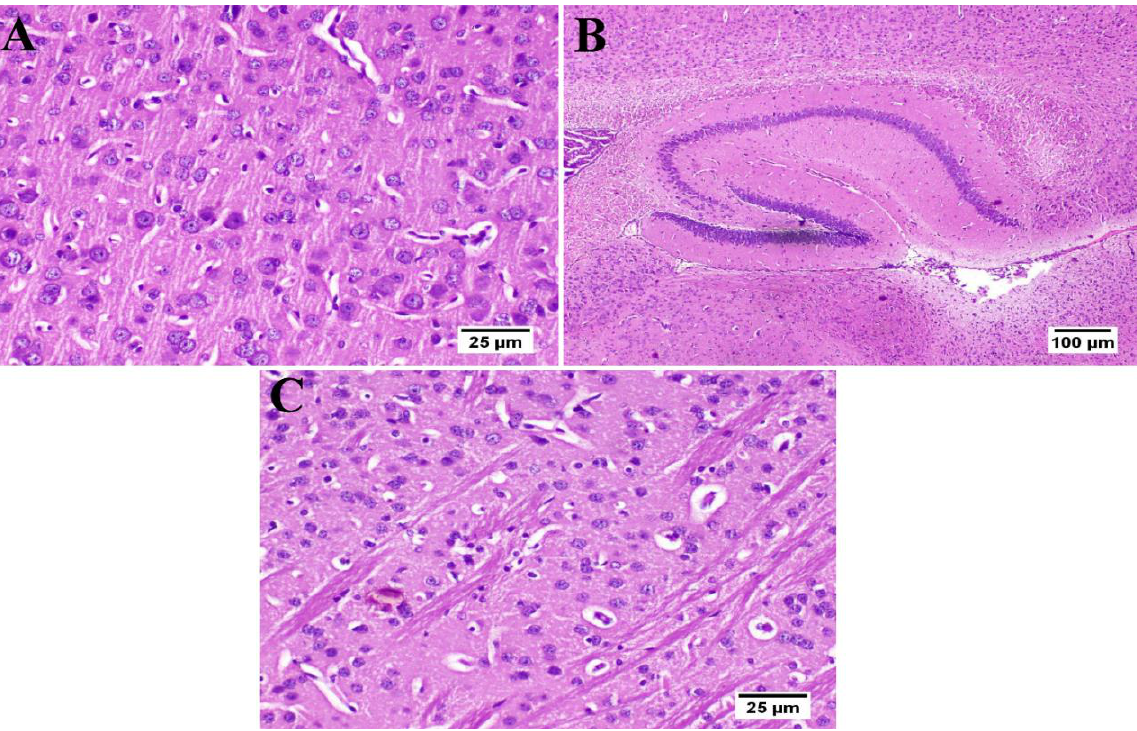
Figure 6. Histology of normal control mice brain (n = 3) (H&E). Normal control mice (group I) showed normal structure of different neurons in the ( A ) cerebral cortex, ( B ) hippocampus, and ( C ) striatum.